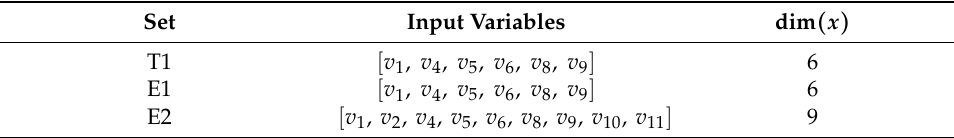
Table 2. Composition of the input vector for each